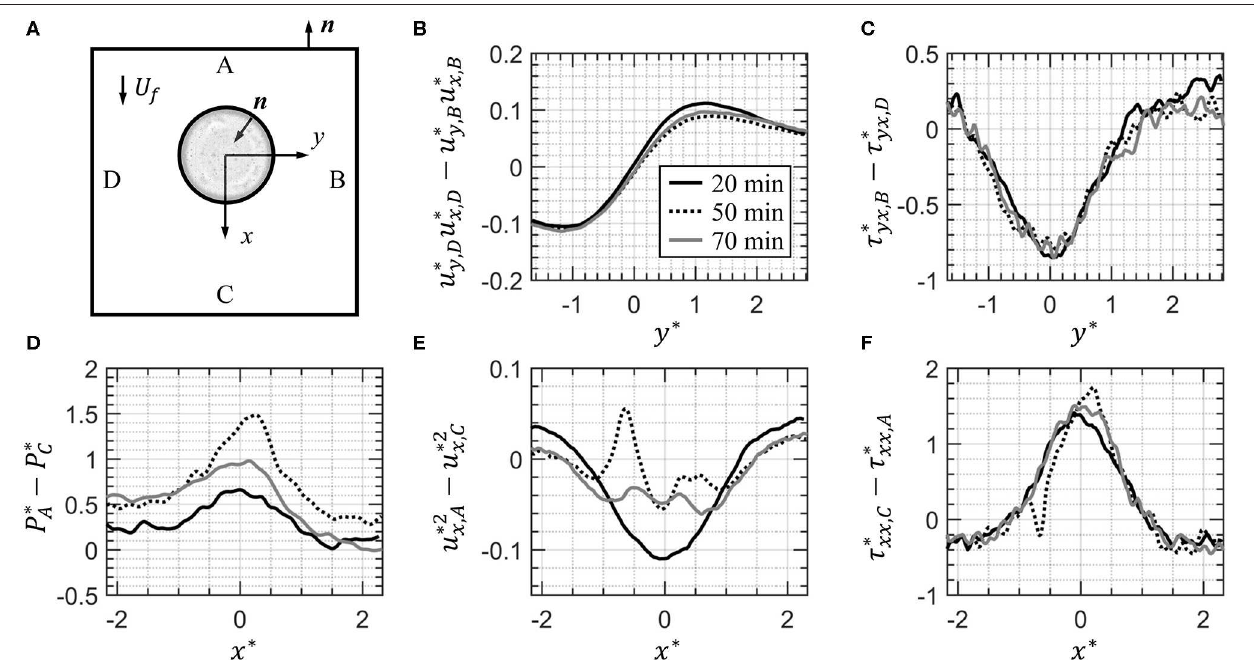
FIGURE 8 | In (A) the control region ABCD is shown again for convenience. In (B–F) the terms from Eq. (4) contributing to the drag force on the drop are plotted for the drop prior to attached bacteria (20min, Figure 3 ), after attachment of several streamers on the trailing half of the drop (50min, Figure 5 ), and after one streamer present at 50min has detached (70min, Figure 7B ). The area under the curve in each plot is added together to determine the drag at each instant in time according to Eq. (4).